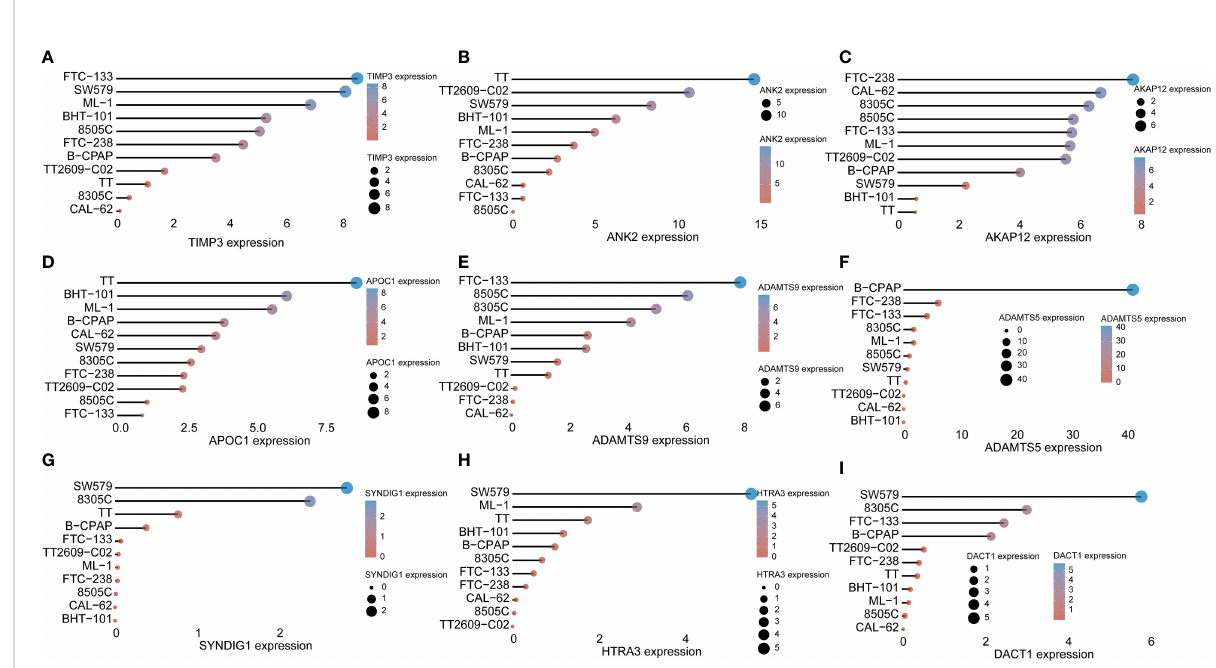
FIGURE 7 Immune prognostic factors expressed in CCLE data Veri fi cation (A-I) AKAP12, APOC1, TIMP3, ADAMTS9, ANK2, HTRA3, SYNDIG1, ADAMTS5, and DACT1 Nine immune-related prognostic factors in TT, BHT-101, ML-1, B-CPAP, the expression of 11 thyroid cancer cell lines including CAL-62, SW579, 8305C, FTC-238, TT2609-CO2, 8505C, and